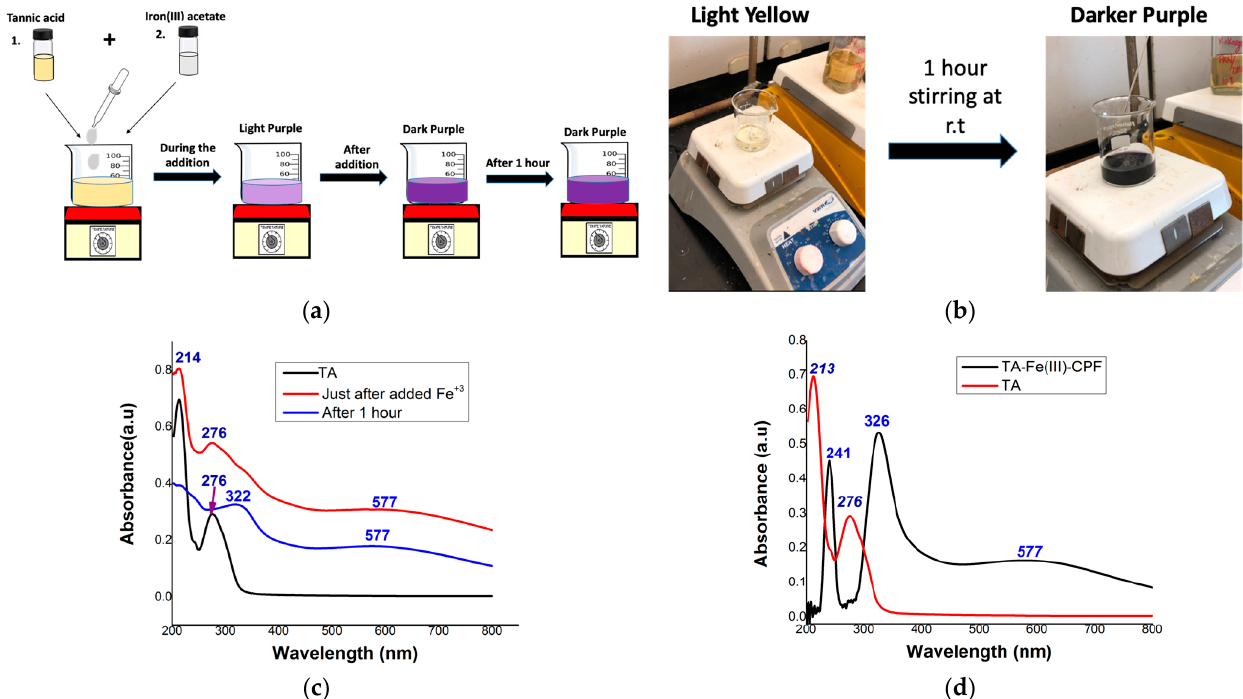
Figure 1. ( a ) Color changes during the reaction progress. ( b ) Images taken before addition of Fe +3 solution and after 1 h of reaction time. ( c ) Respective UV-visible spectral traces collected during the reaction progress. ( d ) A comparison of UV-visible spectra of tannic acid (TA) and purified and re- dispersed Fe(III)-TA microstructures in ethanol.